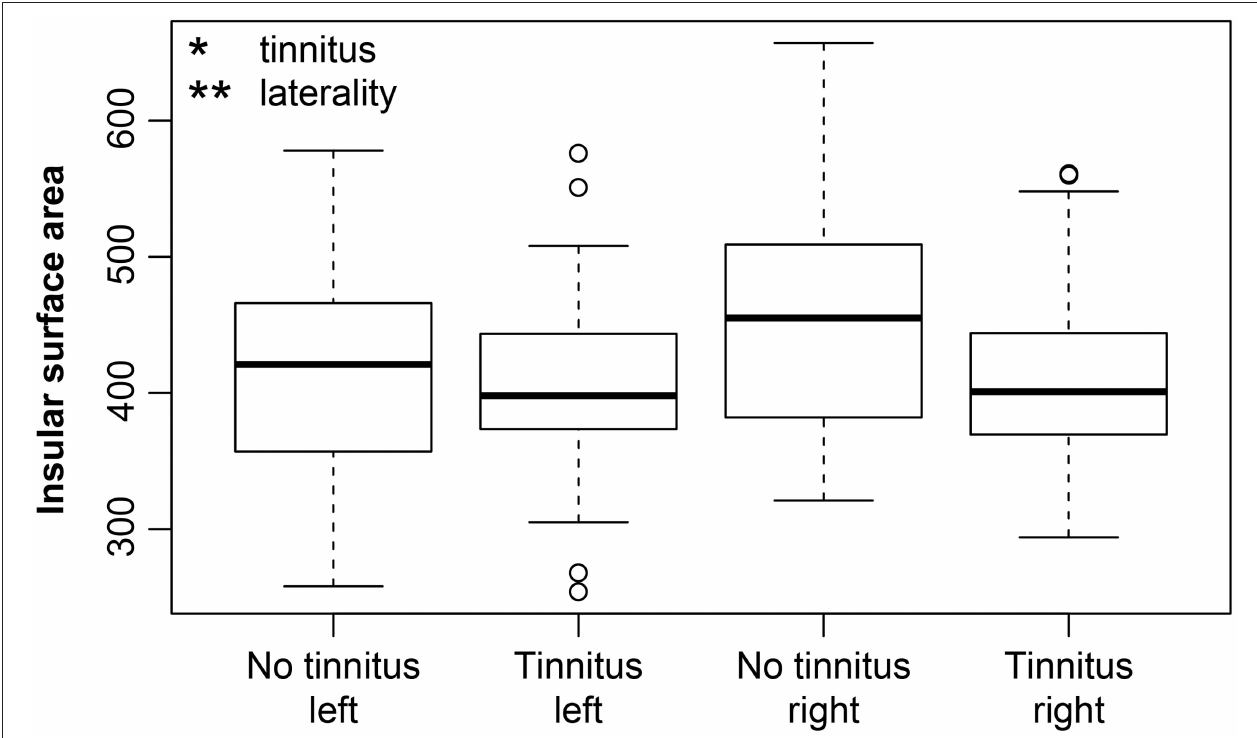
FIGURE 4 | Insular surface remains stable with increasing age however, tinnitus leads to its decrease. Insular surface area is also significantly larger in the right hemisphere (laterality). The effect of tinnitus on insular surface area is independent of age or laterality. Tinnitus—include all groups with tinnitus (Y-NH-T, O-NH-T, O-HL-T), no tinnitus—include all groups without tinnitus (Y-NH-NT, O-NH-NT, O-HL-NT); right and left include data from right and left insula. * p < 0.05, ** p < 0.001